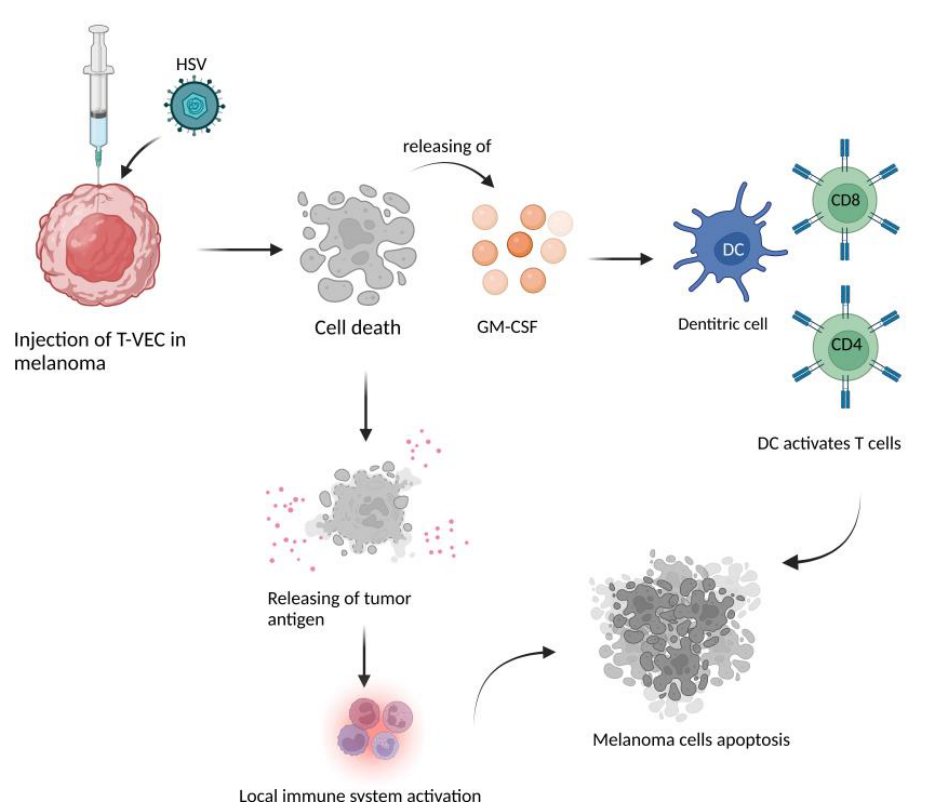
Figure 3. T-VEC is subcutaneously injected directly into the site of cancer. T-VEc attacks the melanoma cells locally, but also triggers the release of GM-CSF which recruits and actives dendritic cells. Dendritic cells activate CD8+ and CD4+ cells which, in turn, attack melanoma causing cell apoptosis and tumor reduction. Created with BioRender.com.